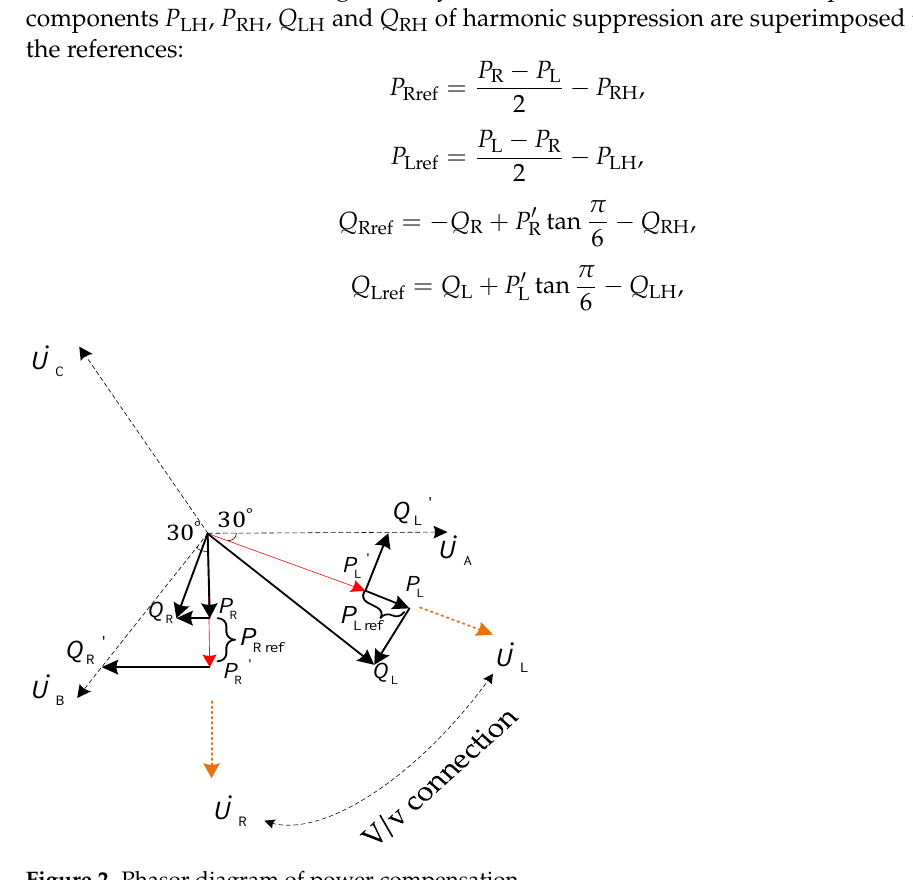
Figure 2. Phasor diagram of power compensation.